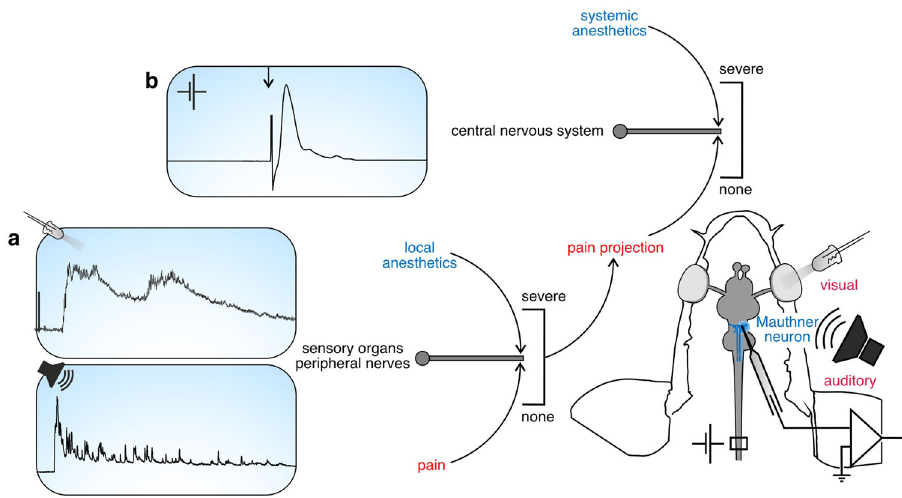
Fig. 1 Brief overview of how the Mauthner neuron can be used to examine the mode of action of anesthetics. Intracellular in vivo recording in the Mauthner neuron (MN) of the gold fi sh provides a comprehensive and rapid assay of targets an anesthetic can act on. a Its function as a command neuron for life-saving escapes requires the MN to faithfully process information forwarded from almost all senses. So, recording of postsynaptic potentials after sensory stimulation (e.g., visual or acoustic) can reveal whether the anesthetic affects different sensory organs directly, the transmission of sensory information to the MN or the processing within the MN. b The systemic effect an anesthetic can have on central neurons by affecting ion channels and the generation and axonal conduction of action potentials can be studied by antidromically activating the Mauthner